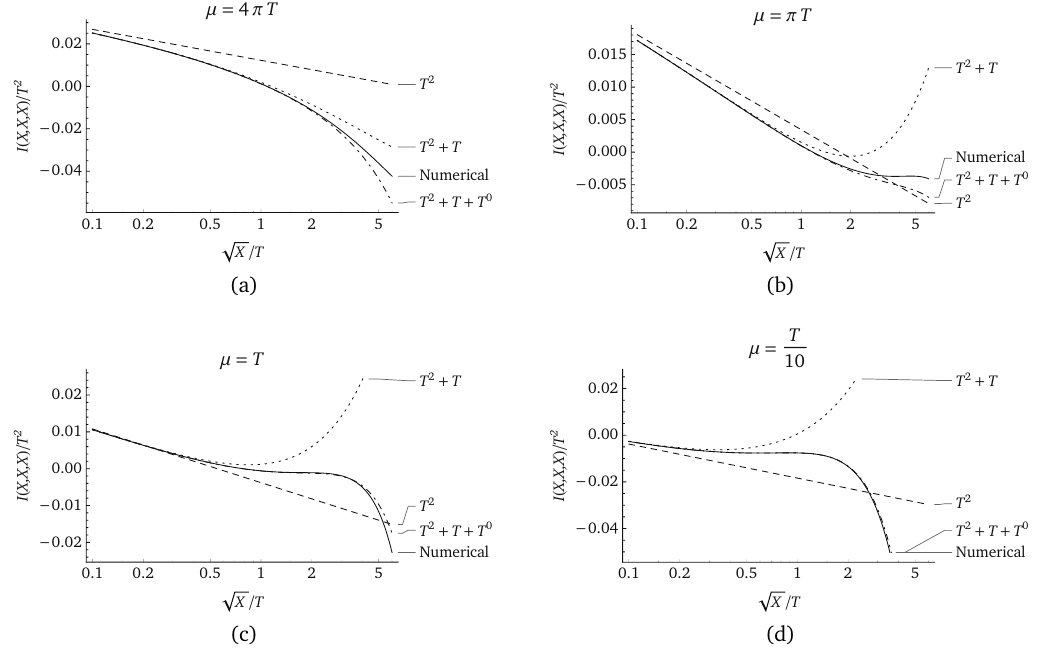
Figure 1: Comparison of the Bosonic high-temperature expansion with the numerical results for various µ = cT scalings. All masses are equal and the sunset integral is normalized with T − 2 . Comparison when (a) µ = 4 π T , (b) µ = π T , (c) µ = T , and (d) µ = T / 10